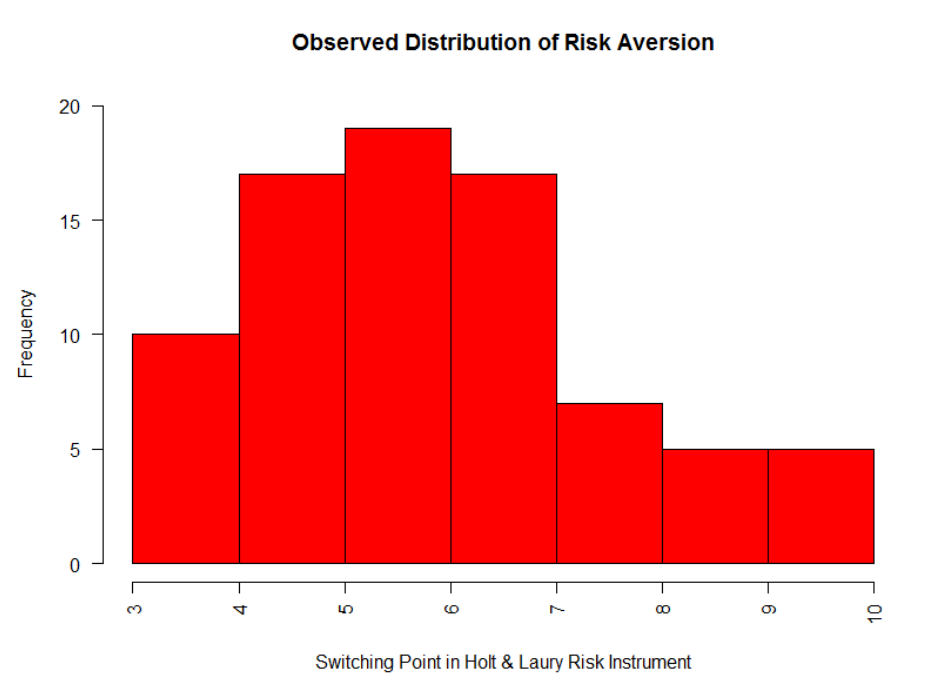
Figure 3. Distribution of the Holt and Laury risk lottery switching